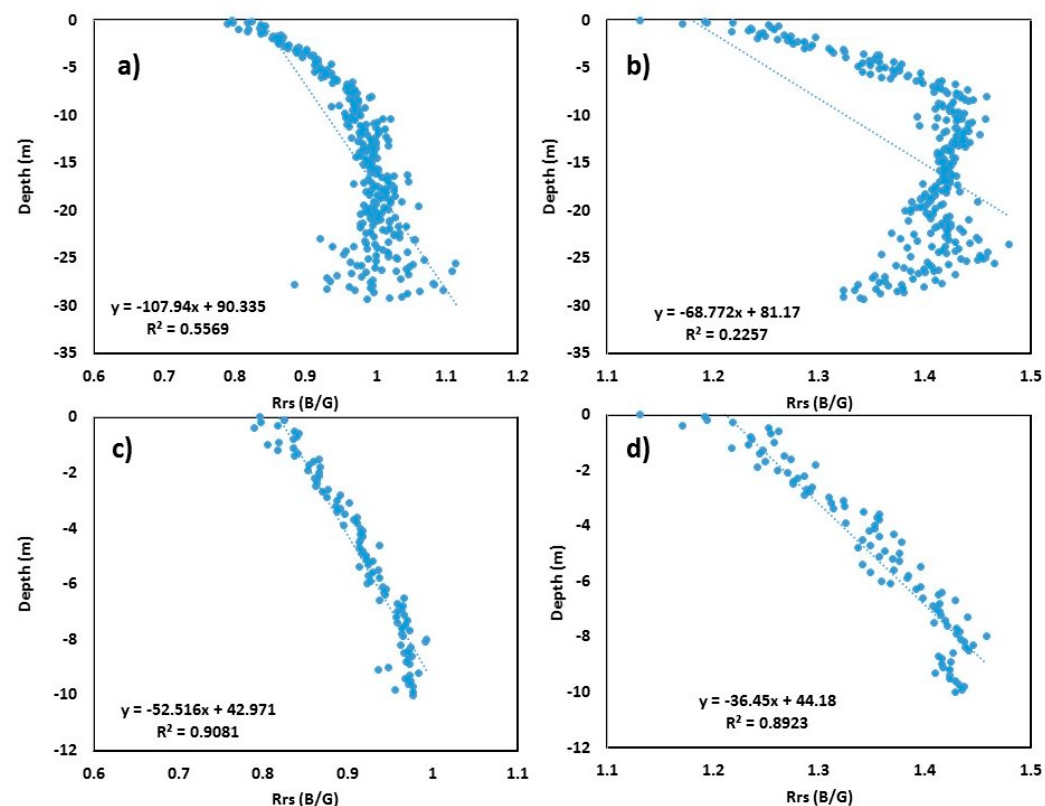
Figure 3. Scatter plots of blue / green (B / G) band versus surveyed depth for Mobile Bay: ( a ) Sentinel-2 B / G vs. surveyed bathymetry up to 30 m depth; ( b ) Landsat-8 B / G vs. surveyed bathymetry up to 30 m depth; ( c ) Sentinel-2 B / G vs. surveyed bathymetry up to 10 m depth; ( d ) Landsat-8 B / G vs. surveyed bathymetry up to 10 m depth.